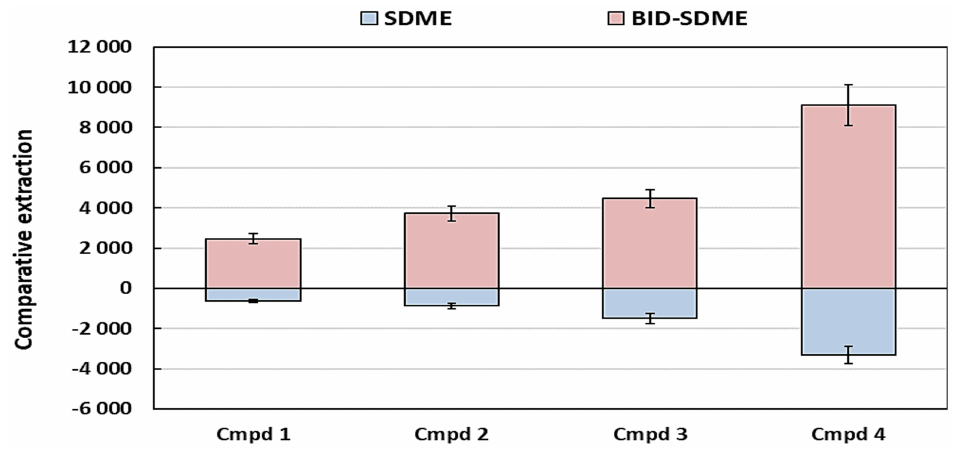
Figure 6. Back-to-back comparison of the SDME and BID-SDME techniques using 2 µ L heptadecane with 15-min equilibration at 55 ◦ C and a sample volume of 1.5 mL. The bars indicate the magnitude of the relative peak areas, while the error bars represent the standard deviations of the triplicate